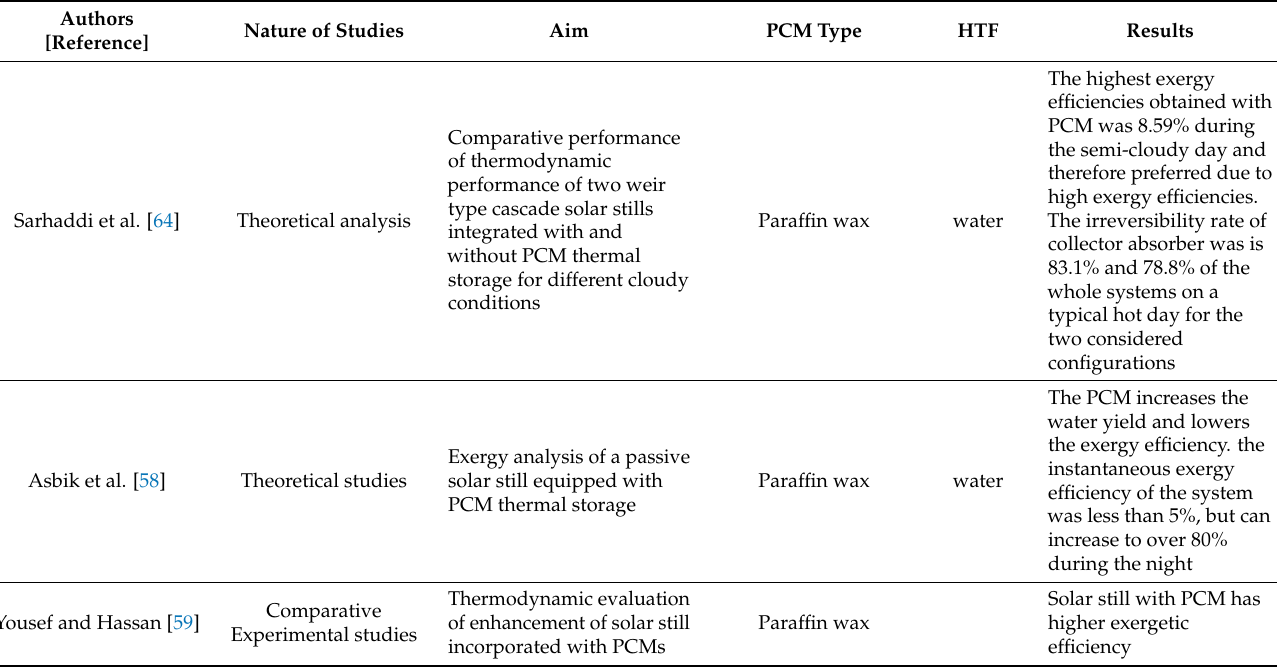
Table 5. Results of some of the studies presented on solar still and the PCM